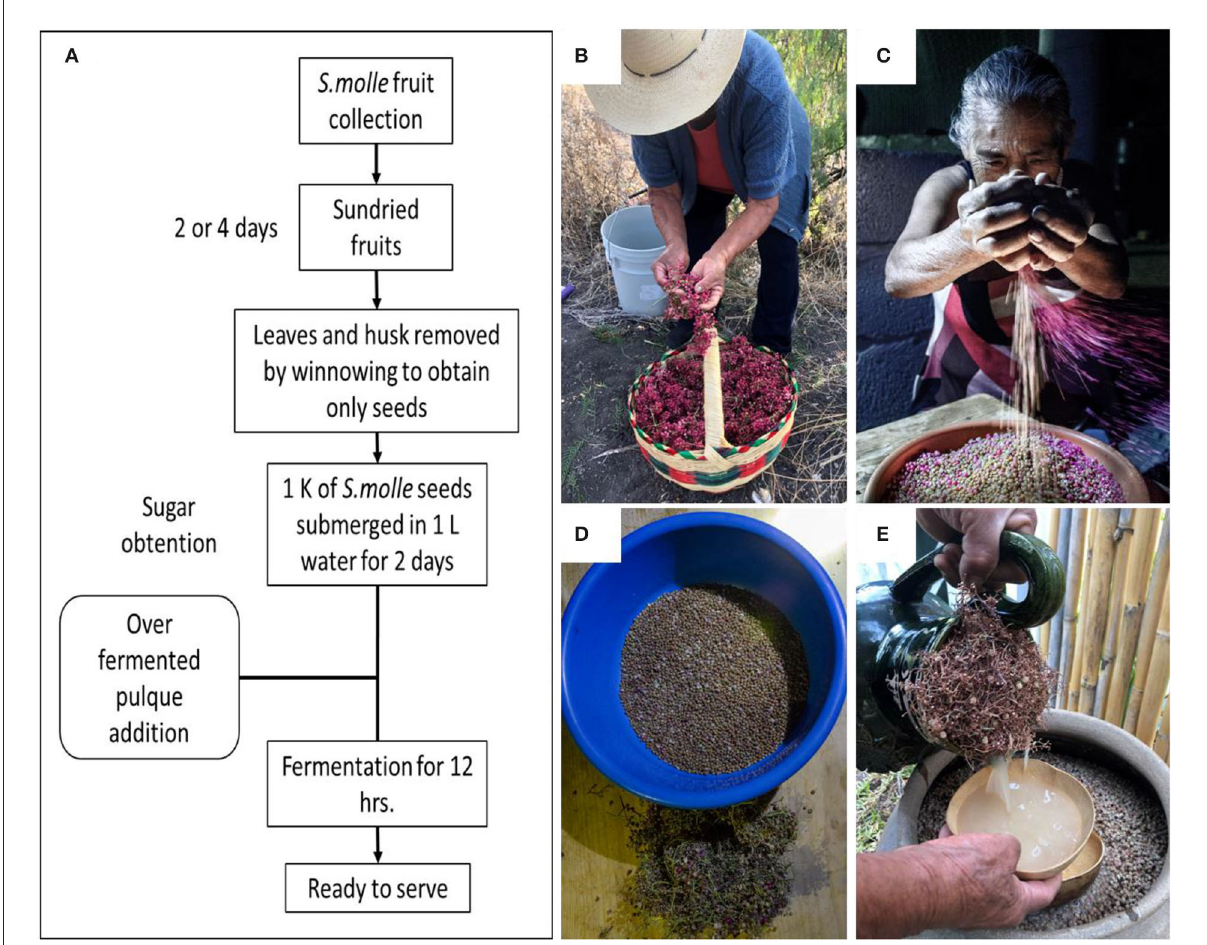
FIGURE4 A general process for tolonche production. (A) A scheme for tolonche production; (B) Recollection of S. molle seeds; (C) Removing the hull from the seeds; (D) Watering the fruits of S. molle to obtain the sugar and flavor, and (E) Pulque addition for a shorter fermentation